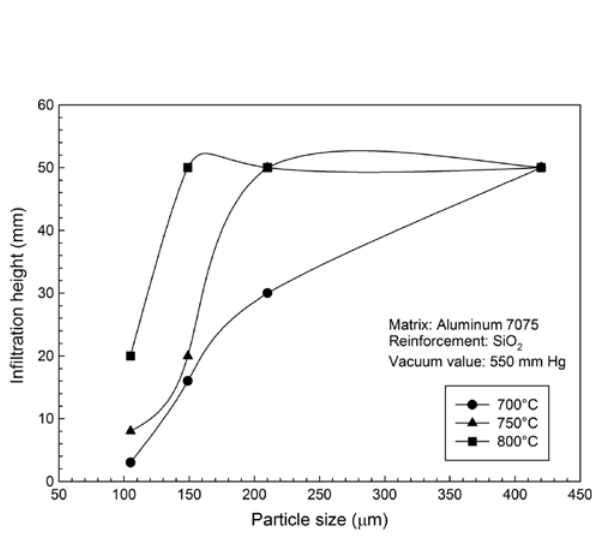
Figure 3: Infiltration heights against reinforcement particle size and matrix temperature.